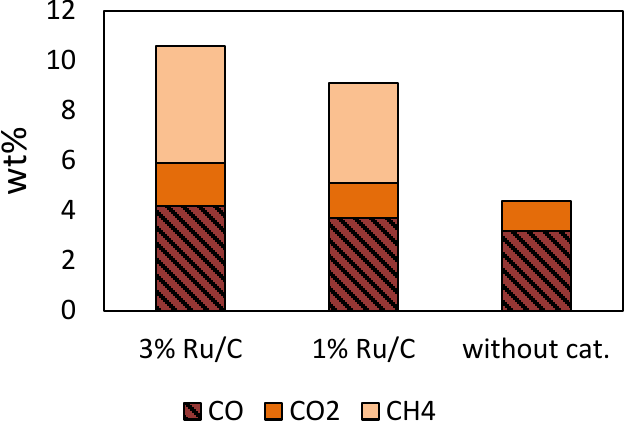
Figure 7. The effect of Ru content on the yield and composition of the gaseous products of spruce wood RCF at 225 ◦ C for 3 h.